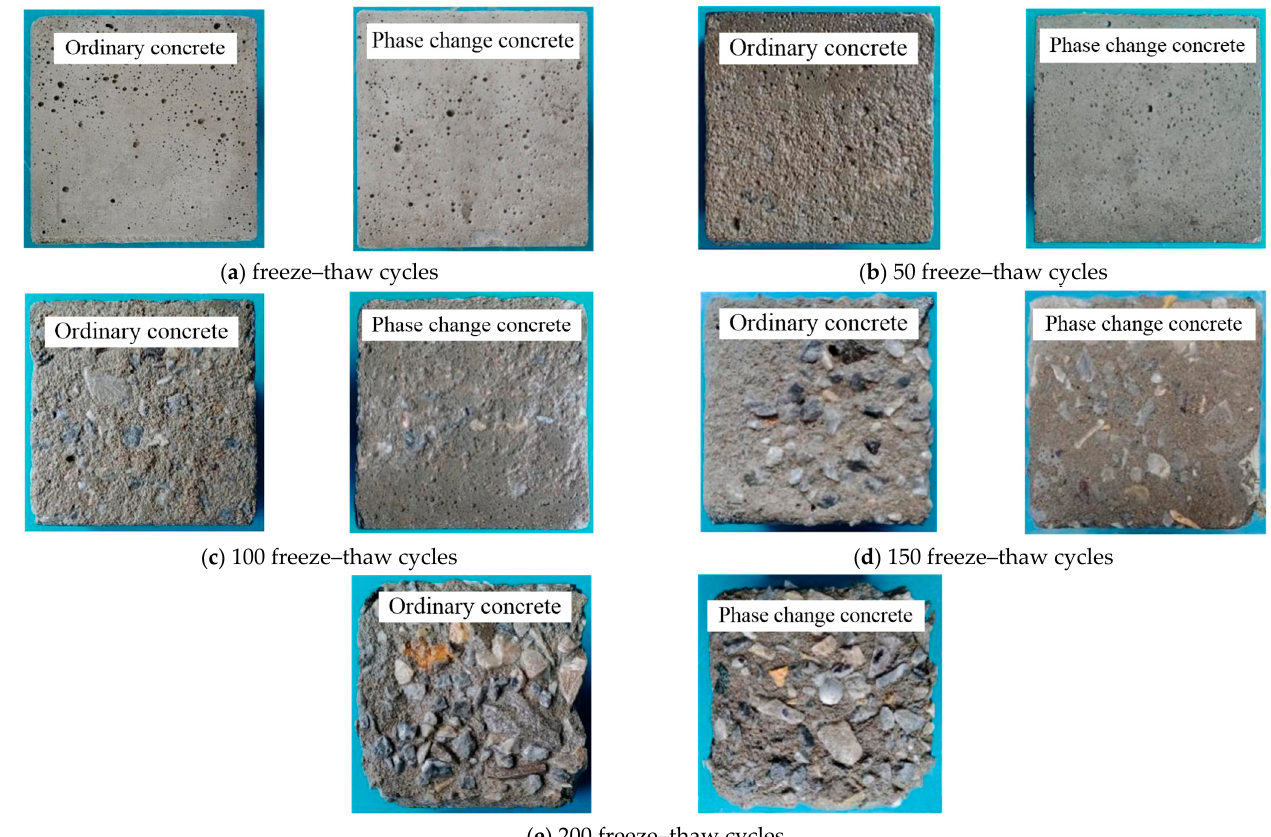
Figure 6. Comparison of concrete surface spalling after freezing and thawing.